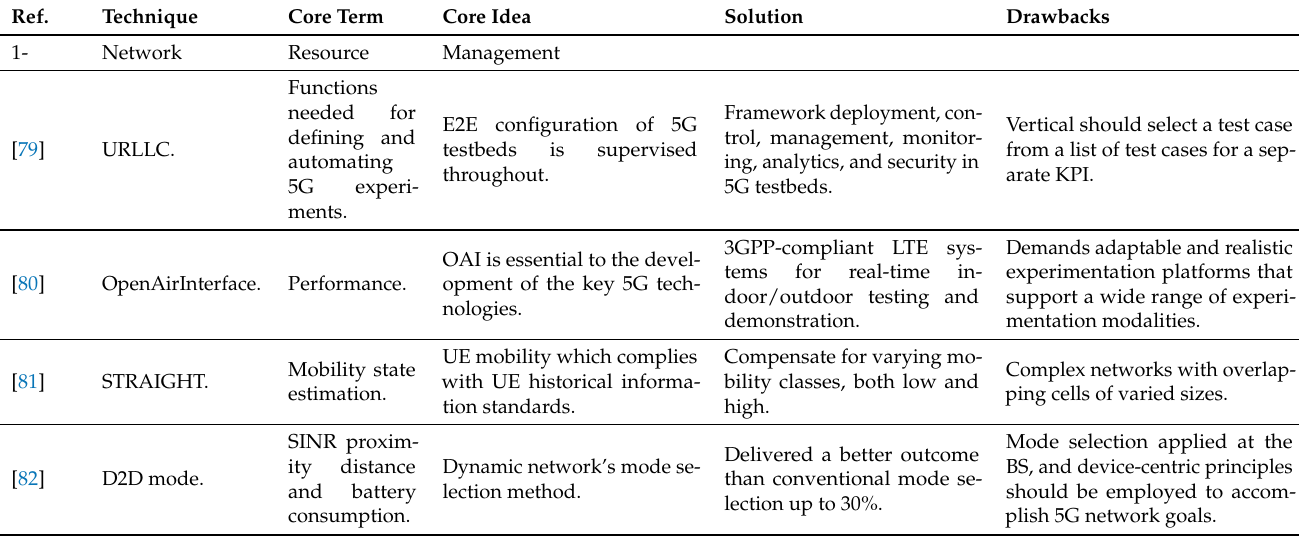
Table 2. Overview of Existing